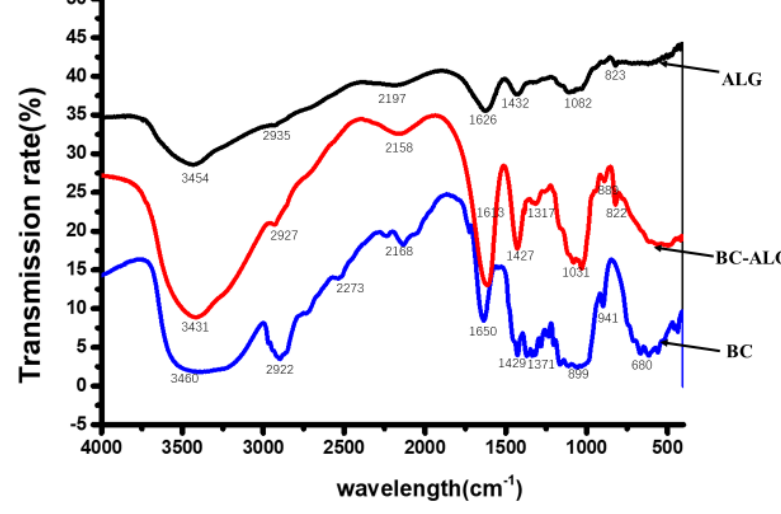
Figure 4. FTIR spectra of ALG, BC-ALG and BC.